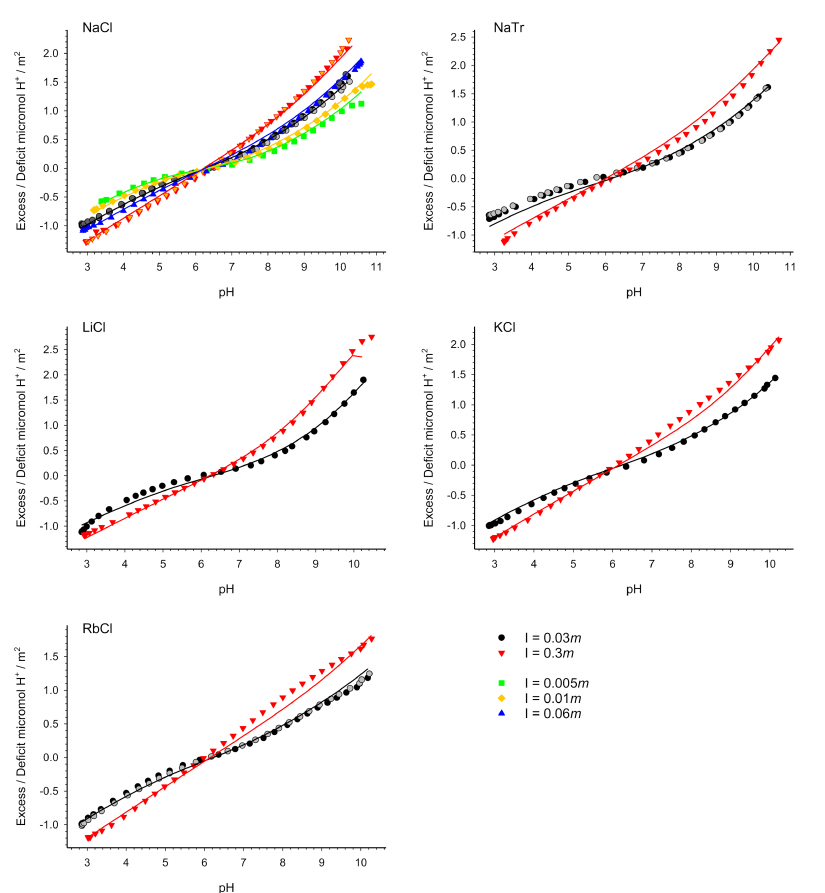
Figure 1. Relative proton adsorption or desorption on the 4 nm sized anatase sample in each electrolyte media. The symbols represent experimental data, and lines represent the SCM best fits. The model parameters are defined in the text and are given in Tables 1 and